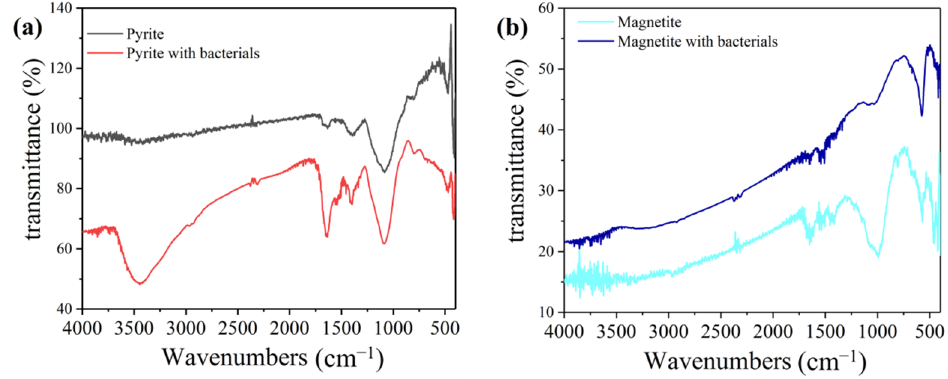
Figure 4. FTIR analysis of pyrite and magnetite in different Cr (VI) reduction systems: ( a ) pyrite group, ( b ) magnetite group.